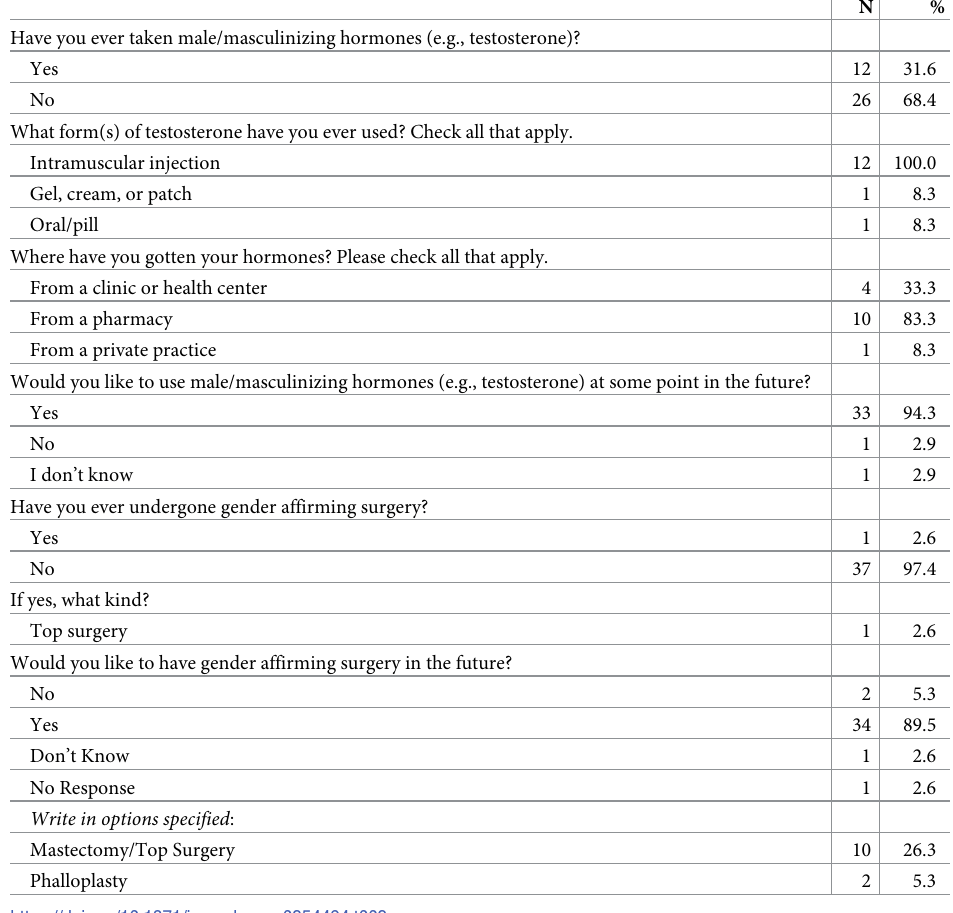
Table 2. Medical gender affirmation in the study sample of trans men in Lima, Peru (n = 46). Have you ever taken male/masculinizing hormones (e.g., testosterone)?